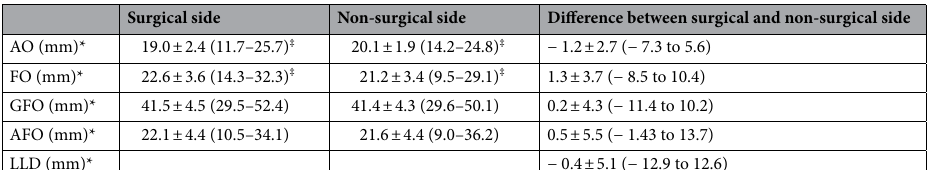
Surgical side Non-surgical side Difference between surgical and non-surgical